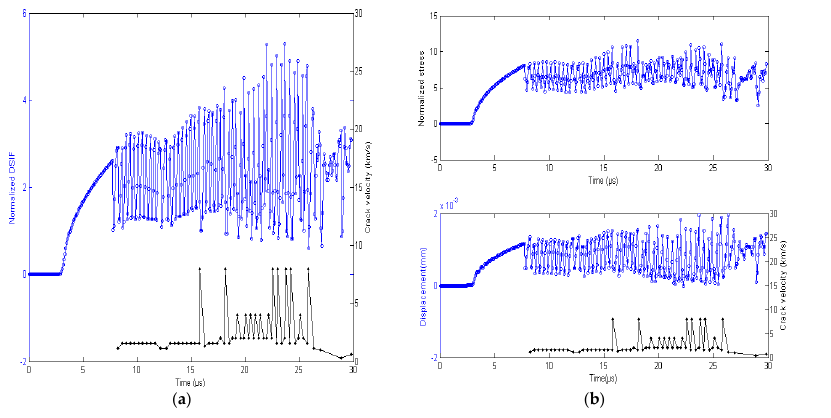
Figure 13. Dynamic stress intensity factor ( ) and crack propagation speed ( ) for = σ ( a ); and the stress and displacement near the crack tip for 650 MPa 650 MPa Figure 11. Dynamic stress intensity factor ( ) and crack propagation speed ( ) for c =σ ( a ); and the stress and displacement near the crack tip for 450 M P a =σ ( a ); and the stress and displacement near the crack tip for 450 M P a c c